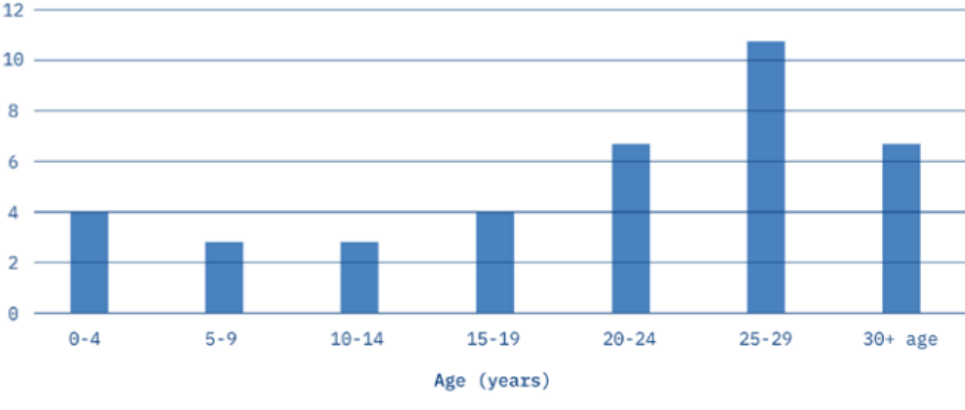
Figure 1. Bulk carrier’s losses as a function of ship’s age (2010–2019)